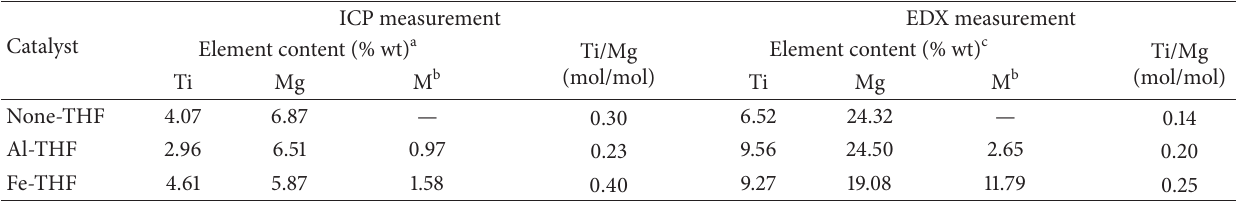
Table 2: The elemental composition of the prepared